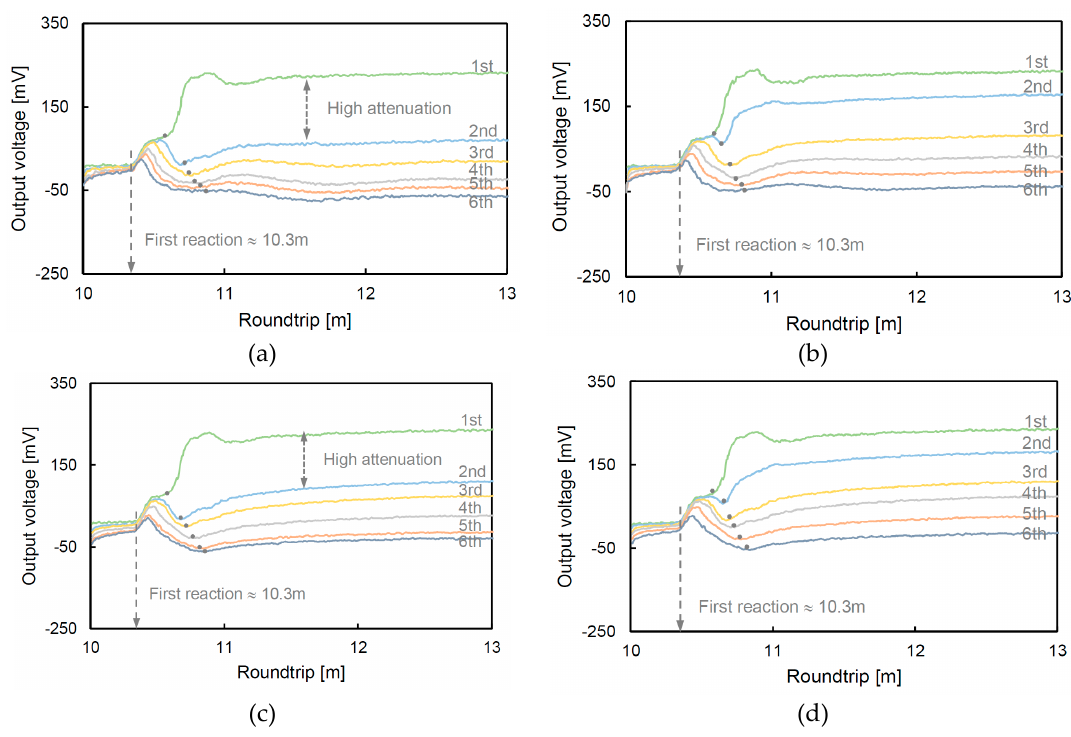
Figure 5. Measured waveforms from TDR: ( a ) glass beads (Dr = 40%); ( b ) glass beads (Dr = 80%); ( c ) soil (Dr = 40%); and ( d ) soil (Dr = 80%). The Dr denotes the relative density, and the dotted points show the reflected positions from the medium.